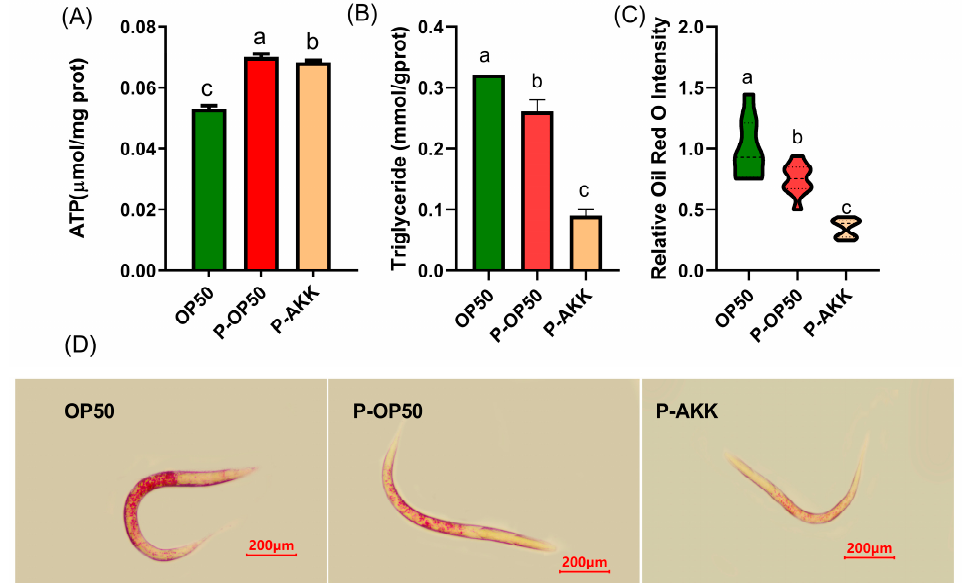
Figure 2. p-AKK enhances cellular energy currency and reduces fat accumulation. N = 3. ( A ) ATP level of C. elegans . ( B ) Triglyceride content of C. elegans . N = 3. ( C ) Quantification of data shown in ( D ). N = 10. ( D ) Oil Red O staining of fixed worms and selected intuitive characteristic map. Bar, 200 µ m. The results are expressed as the mean ± SD and p -values were calculated by Duncan’s tests. Significant differences between groups are expressed by different letters (a–c) ( p < 0.05).